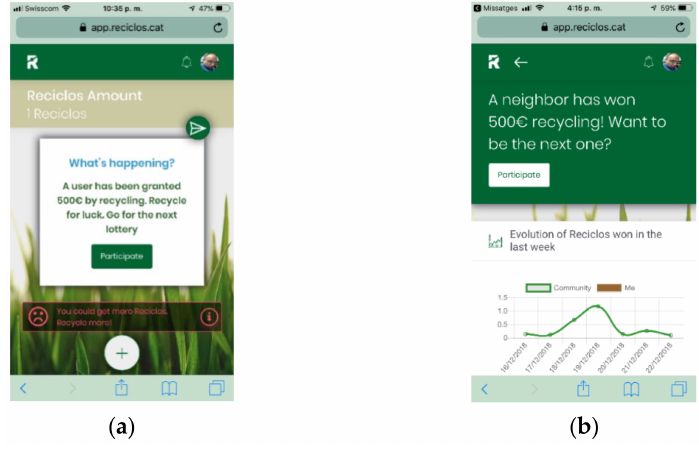
Figure 1. RECICLOS—the user interface; ( a ) homepage; ( b ) example of newsfeed to call to action.